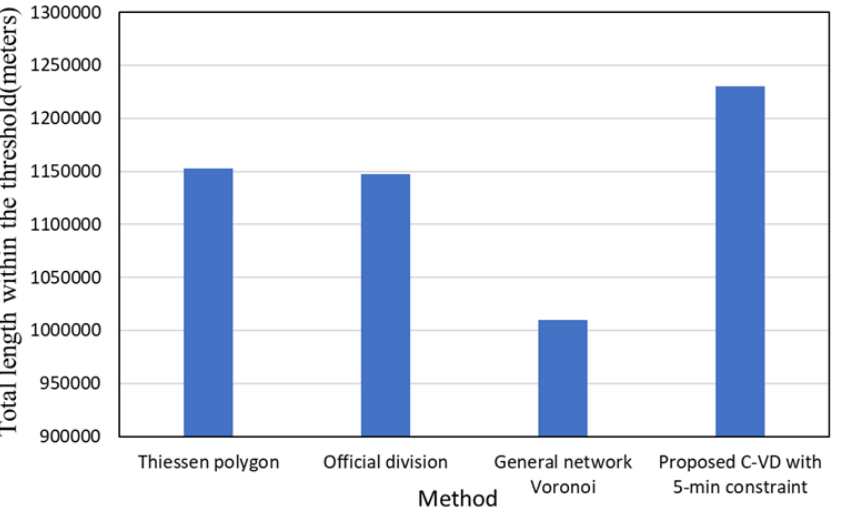
Figure 13. The street segment length of service areas within the Golden 5 min threshold obtained by different methods.